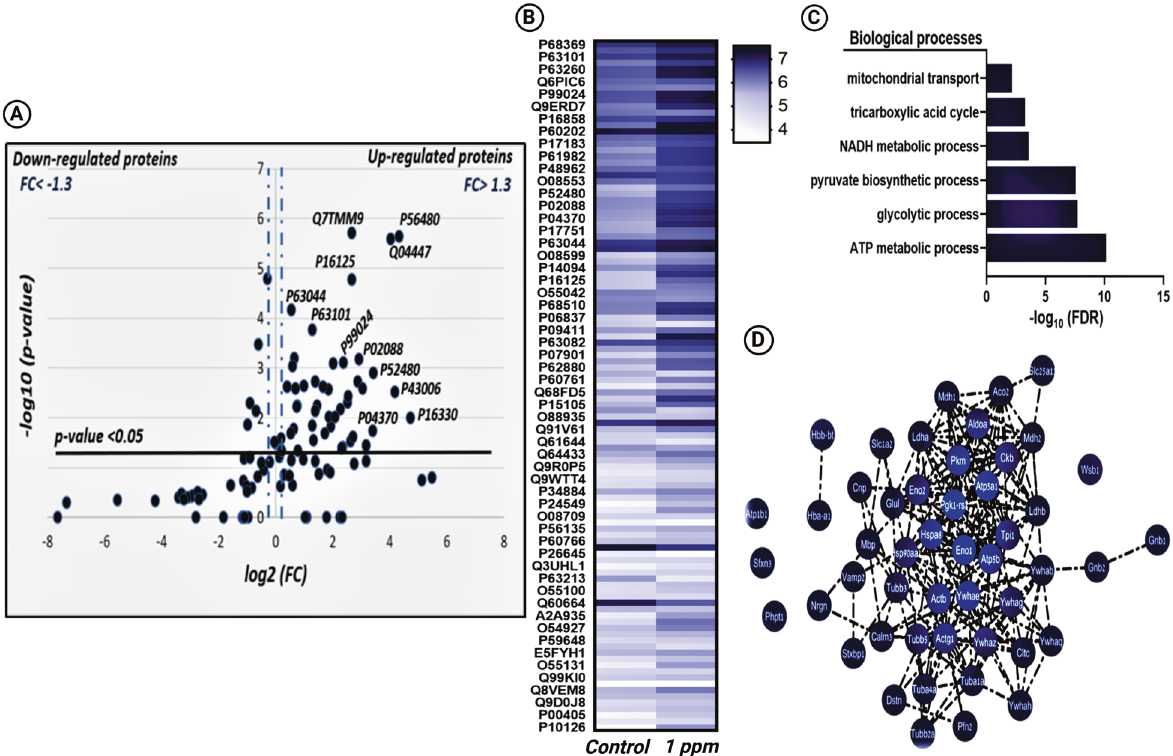
Fig. 2 Quantitative analysis of the SNO-proteins in Striatum of 1 ppm group. A Volcano Plot analysis was conducted on the striatal shared SNO proteins between the control and 1 ppm group. The X -axis represents the fold change (log2(FC)) that was calculated as the difference in the relative abundance of each protein in both tested groups, divided by the relative abundance of the protein in control [FC = (Relative abundance(SA) − Relative abundance (control))/(relative abundance(WT))]. The Y -axis represents the − Log10 of the p -value. The black horizontal line represents a signi fi cance level of P -value = 0.05. The two fragmented vertical lines represent the threshold of the FC = 1.3. Proteins that are upregulated in the 1 ppm group appear on the right side of the plot with statistical signi fi cance of p -value < 0.05 and FC > 1.3 . B Heat map analysis representing the differential relative abundance of the shared SNO-proteins in the control vs 1 ppm group. The relative abundance scale was normalized by – log10 . C BP analysis conducted on the upregulated SNO proteins in the 1 ppm group as compared to the control group . D Clustering analysis of upregulated SNO proteins in the 1 ppm group as compared to the control